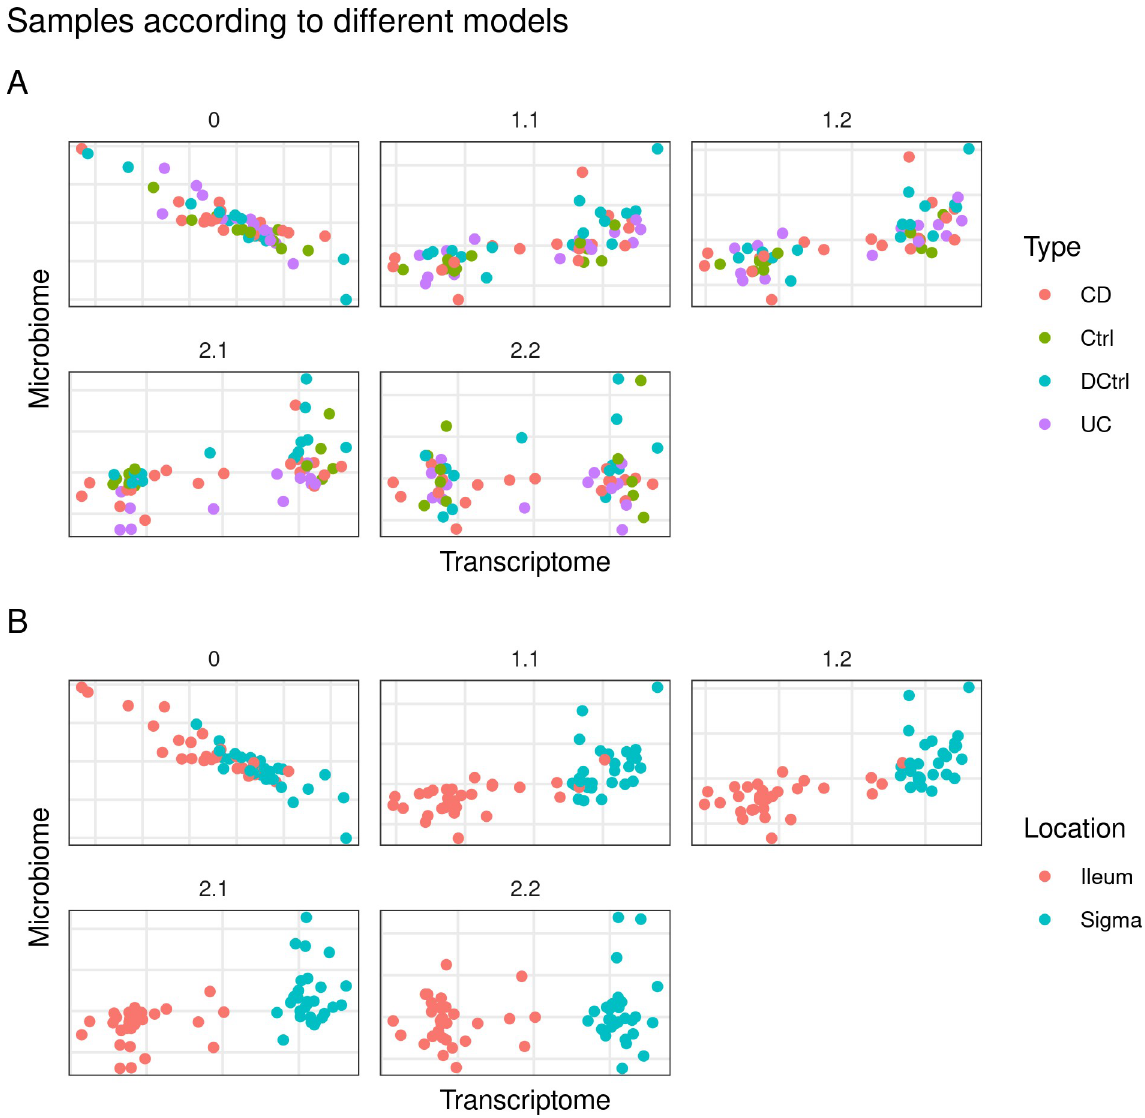
Fig 2. First dimensions of the host transcriptome and the microbiome block of models on the Crohn’s disease ulcerative colitis/ dataset. Comparison of the models that better explained the interaction between the microbiome and the host transcriptome data on the CD/UC dataset. Each point represents a sample colored according to a characteristic: A) samples are colored by disease type, CD Crohn’s disease, Ctrl, control; DCtrl diseased control, inflamed but not from IBD patients, UC ulcerative Colitis; and B, by location, colon or ileum, on the first components of the host transcriptome and the microbiome. Better models separate samples by tissue location using the host transcriptome component.